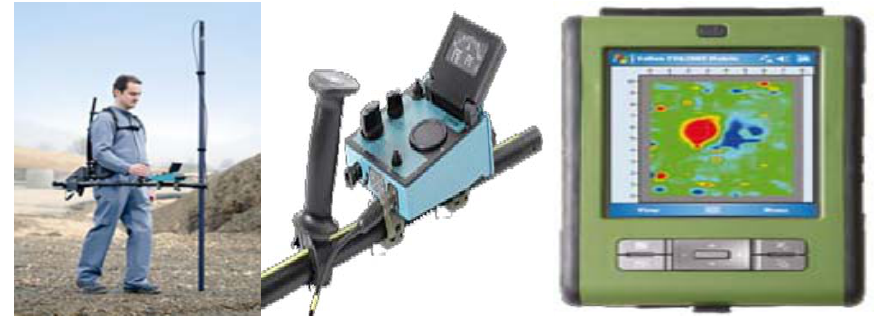
Figure 11 – Metal detector VXT1 Рис . 11 – Металлоискатель VXT1 Слика 11 – Детектор метала